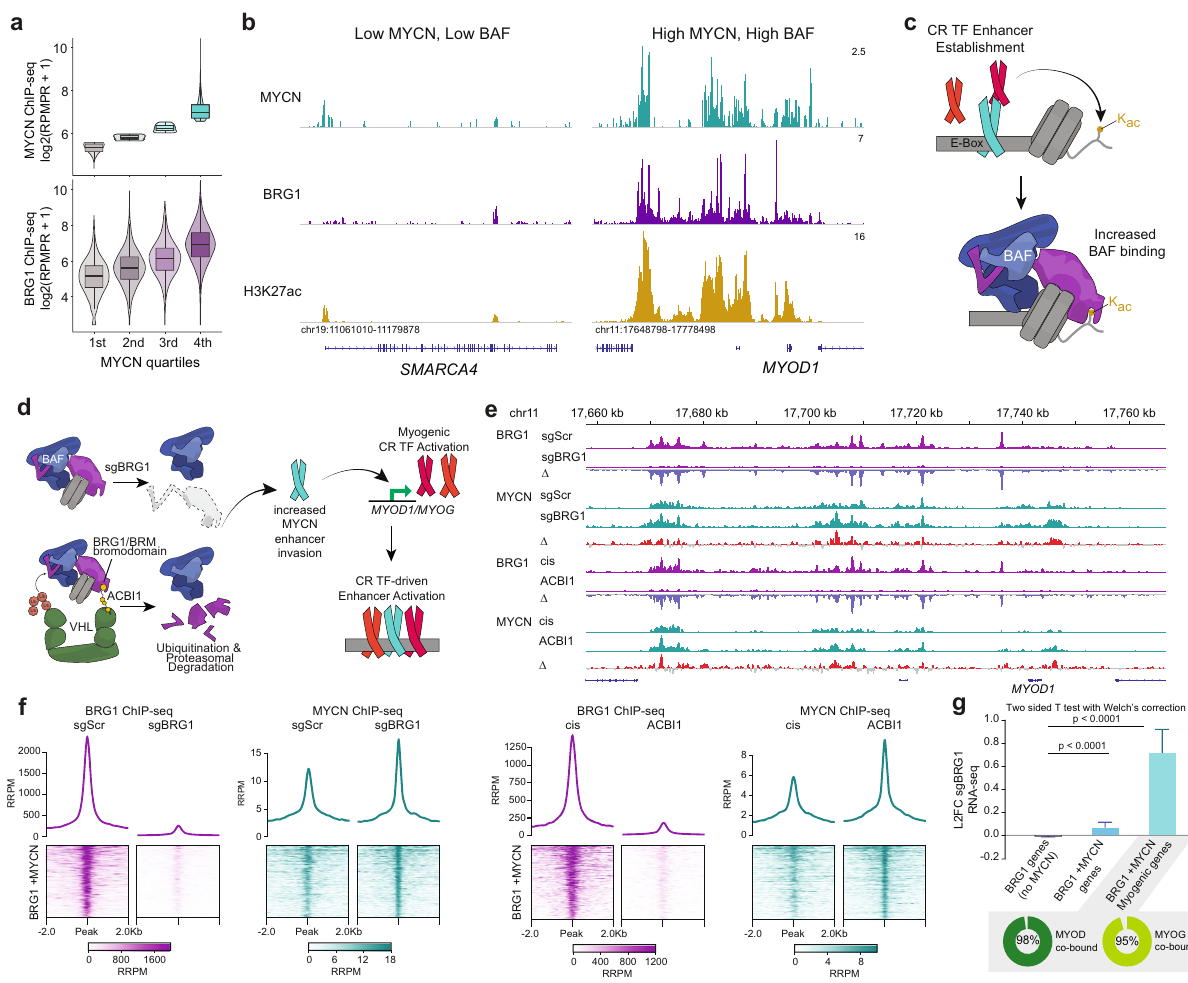
Fig. 5 BRG1 responds to and re fi nes the FP-RMS core transcriptional circuitry. a ChIP-seq peak distribution of BRG1 in comparison to MYCN peak intensities. Subdivision of MYCN peaks into quartiles reveals positive correlation between MYCN and BRG1 binding (Reads Per Millioin Peak Reads (RPMPR)). Violin plots, overlaid with box plots of median and quartiles, with whiskers showing the 1.5 × inter-quartile ranges. Data obtained from single experiments. b ChIP-seq browser tracks of BRG1, MYCN, and H3K27ac for SMARCA4 and MYOD1 associated loci. c Proposed model for CRTF enhancer/ promoter establishment, inducing H3K27 acetylation, leading to recruitment of BAF complexes. d A proposed model for genetic ablation of BRG1 vs. chemical degradation of BRG1/BRM, activating myogenesis. e Browser snapshot of the MYOD1 locus showing binding patterns of BRG1 and MYCN after removal of BRG1 (genetically or chemically). f Genetic or chemical depletion of BRG1 followed by ChIP-Rx (reference exogenous reads per million mapped reads, RRPM) resulting in BRG1 removal yet an increase in MYCN binding at these same co-occupied sites ( n = 1904). g RNA-seq of genes associated with BRG1 only peaks, BRG1 with MYCN sites, or a subset of BRG1 with MYCN at myogenic genes. Data is shown as the median and error bars show the 95% con fi dence interval of the log2 fold change in expression after sgBRG1. Accession details for ChIP-seq data (GSE162052) can be found in the data availability section.